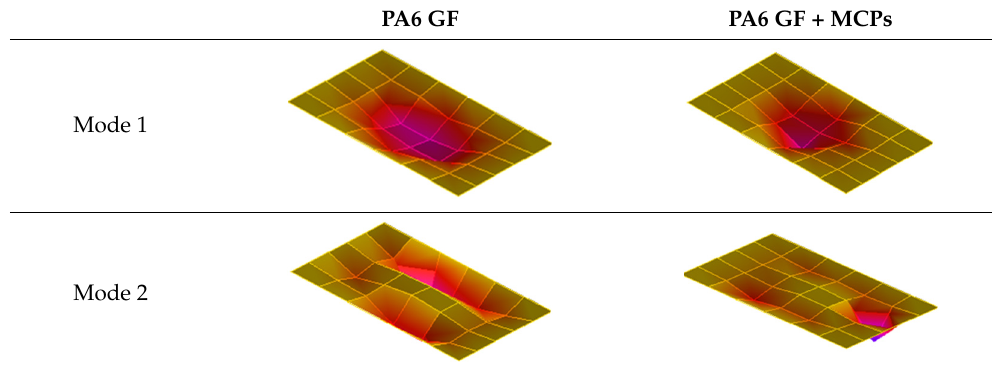
Figure 11. Effects of MCPs on natural frequencies of plate specimen.